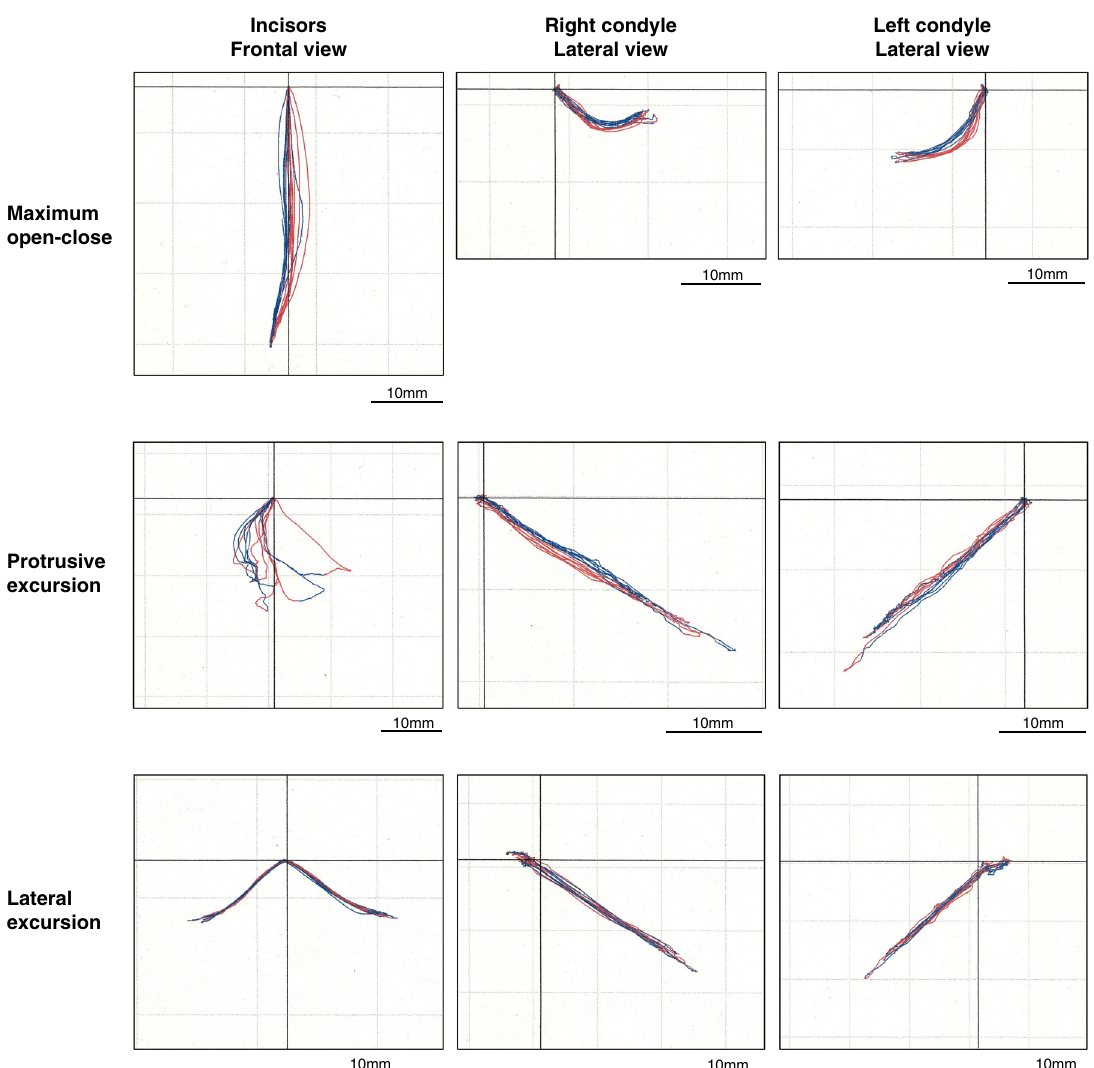
Figure 16. Postretention condylar movements and incisal paths as detected using a 6 degrees of freedom jaw movement recording system. Opening and closing, protrusive, and lateral jaw movements. The red line indicates the opening phase, and the blue line indicates the closing